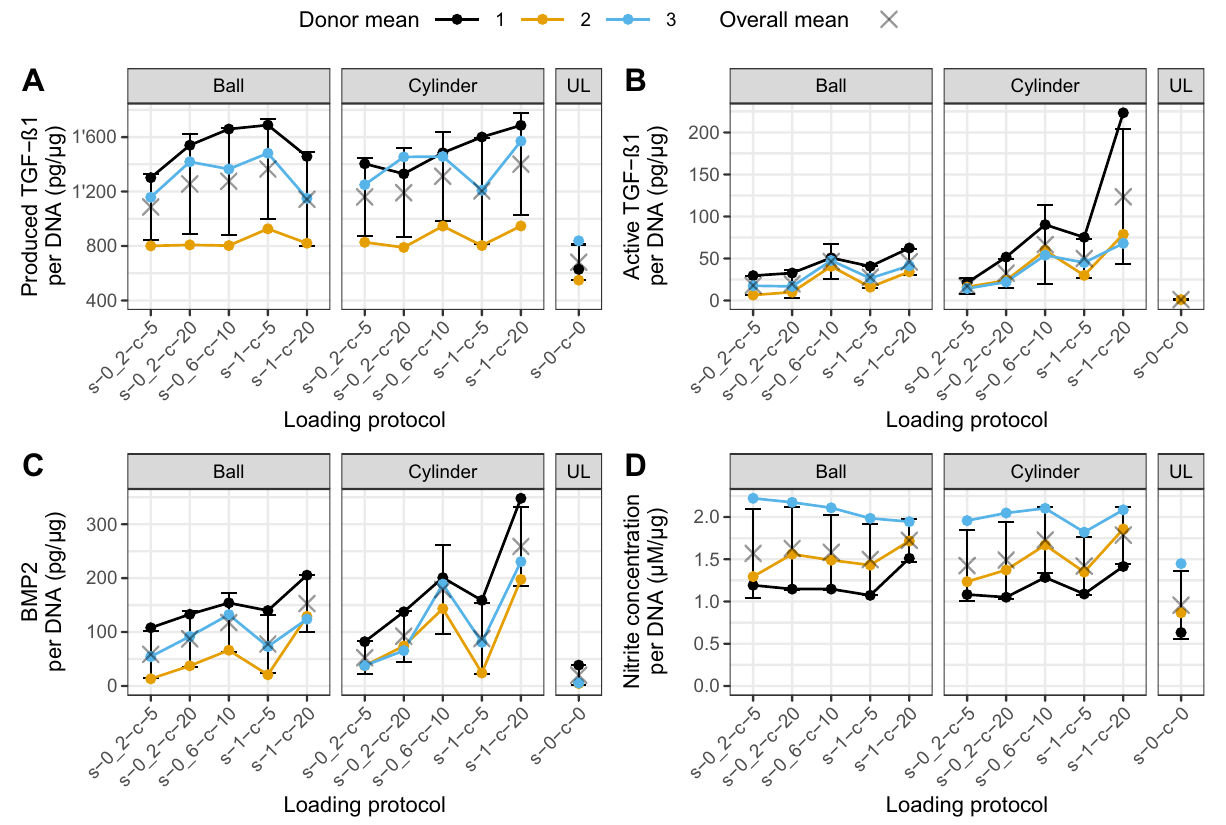
Figure 4. TGF-β1 produced (latent and active), active TGF-β1, BMP2 and nitrite content released by MSCs seeded in fibrin polyurethane scaffolds after 10 load cycles. Produced ( A ) or active ( B ) TGF-β1, BMP2 ( C ) and nitrite ( D ) released by MSCs in loaded scaffolds distinguished by counterface type (Ball and Cylinder) or unloaded (UL) condition and loading protocols. Data are shown as mean ± SEM of three independent experiments with cells from three individual donors. Each experimental group was run in technical replicates. Statistical testing was not performed on single conditions but on contrasts (significant contrasts in Fig. 3; non- significant contrasts in Supp. Figs. 4 and 5). s shear, c